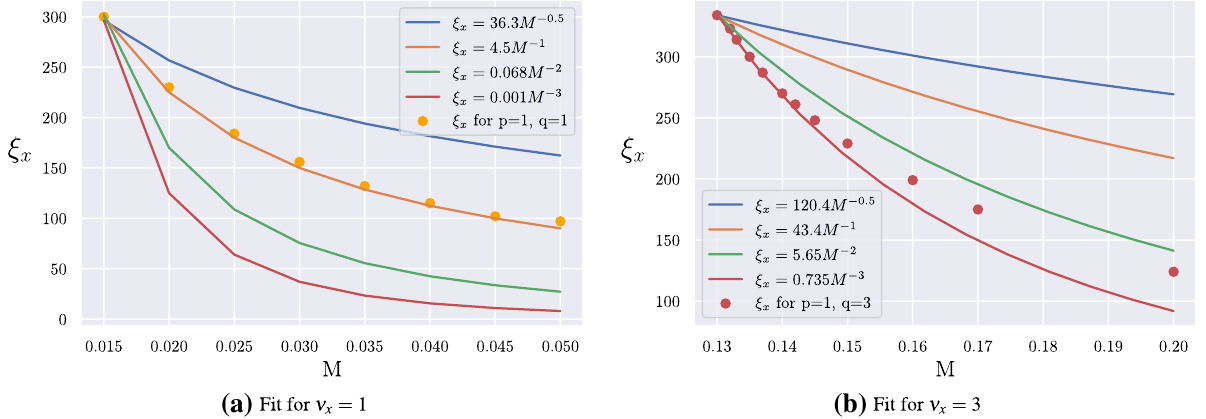
Figure 8. Heatmap of ν x as a function of p and q values. Inserted values indicate ν x for each pair [ p , q ], from 1 p 1 / 2 while for q ν x q / p . For all values investigated, ν x to 8. For q < p 2 , ν x 2 we have ≥ = = equal to unit. The green circles indicate the values related to the topological Hopf insulator phase, i.e., p and q prime to each other 57 .